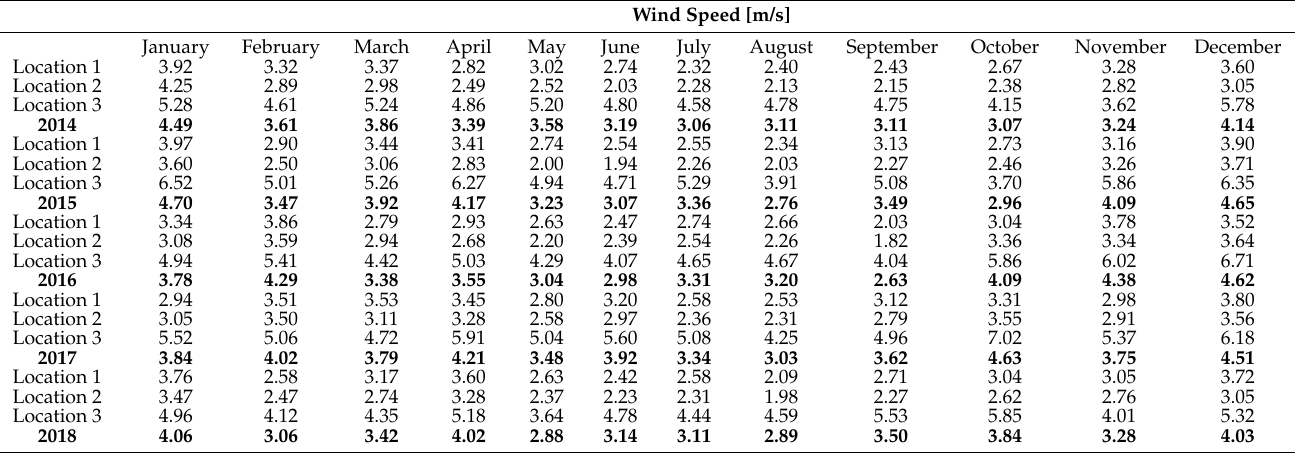
Table A2. Distribution of average monthly wind speed at the three locations for the period